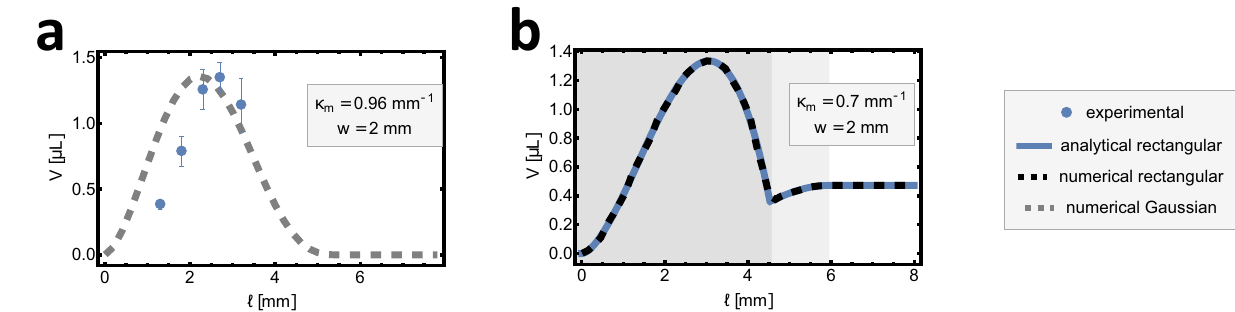
b Theoretical plot for a rectangular stimulus pro fi le, in which the background colouring follows the same convention as in Fig. 3.